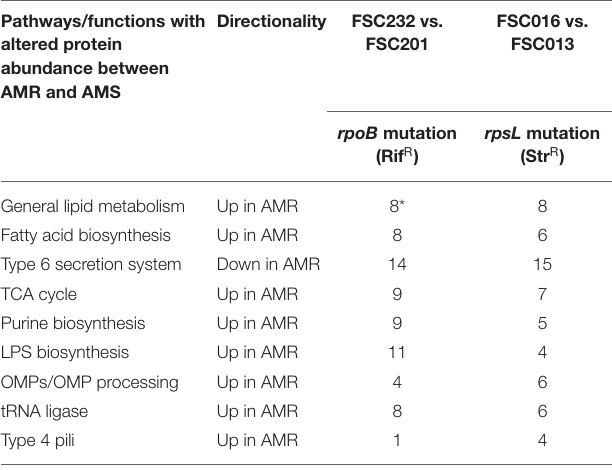
TABLE 3 | Major F. tularensis cellular functions and pathways influenced by AMR